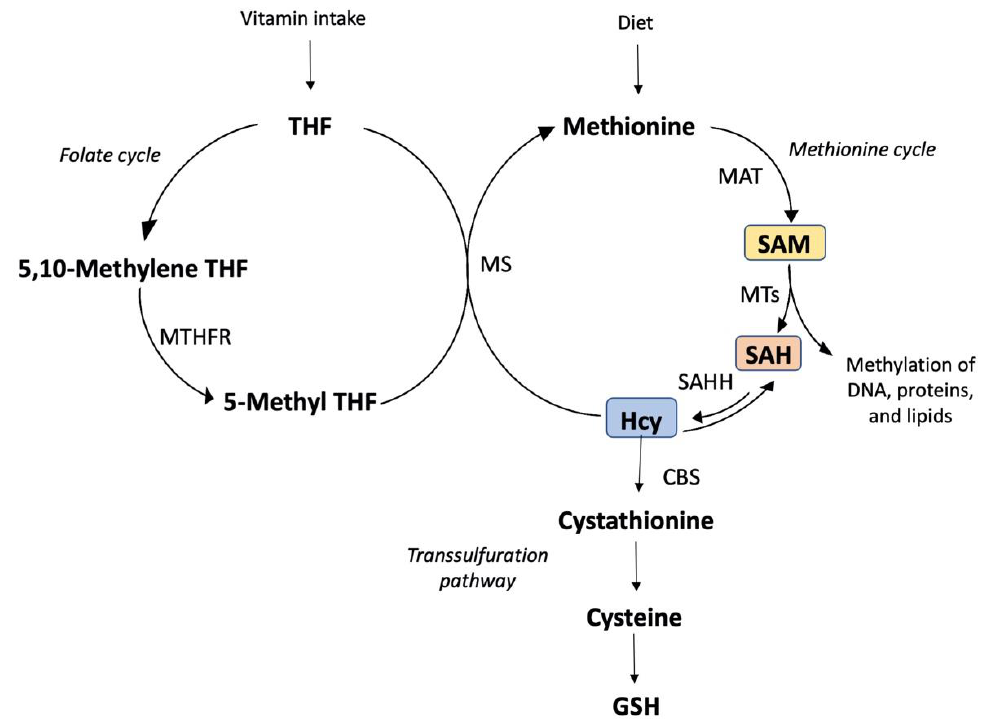
Figure 3. Vitamins and their possible mechanisms of action against the liver injury caused by al- cohol consumption. Tetrahydrofolate (THF), 5,10-methylenetetrahydrofolate (5,10-Methylene THF), methylenetetrahydrofolate reductase (MTHFR), and 5-methyltetrahydrofolate (5-Methyl THF), the initial methyl donor for transmethylation processes, are all involved in vitamin metabolism. 5-Methyl THF and homocysteine (Hcy) are substrates for methionine synthase (MS) in the synthesis of methionine, which is converted to S-adenosylmethionine (SAM) by methionine adenosyltransferase (MAT) in transmethylation processes. S-adenosylhomocysteine (SAH) is a product and inhibitor of methyltransferase reaction (MTs) as well as a substrate for the bidirectional enzyme SAH hydrolase (SAHH), which creates homocysteine or SAH when SAH is in excess. Hcy is metabolized by cystathionine beta-synthase (CBS) and cystathionase to produce cysteine and glutathione (GSH) in transsulfuration processes. It is also important to note that SAM inhibits MTHFR while promoting CBS expression. As a result, a SAM shortage boosts 5-Methyl THF production while lowering 5,10-Methyl THF and GSH production.